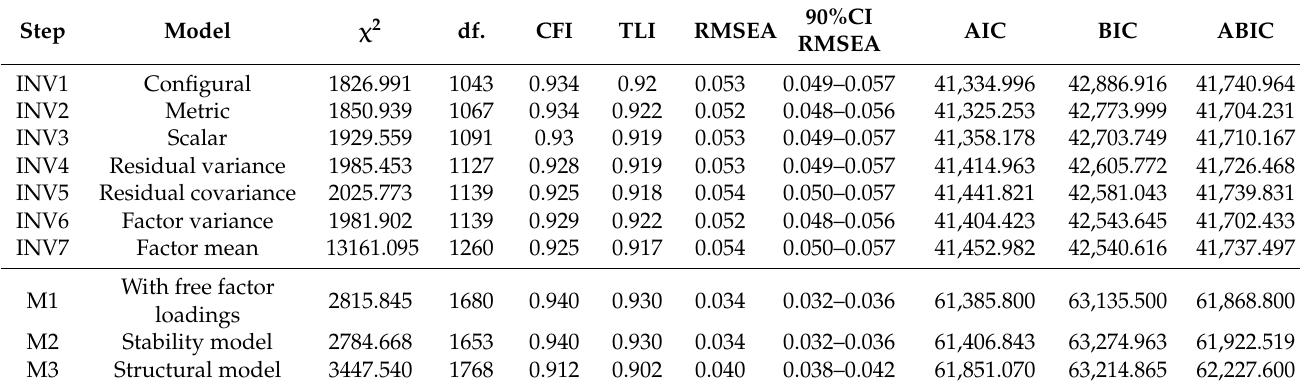
Table 2. Fit Indices for the Measurement Models.